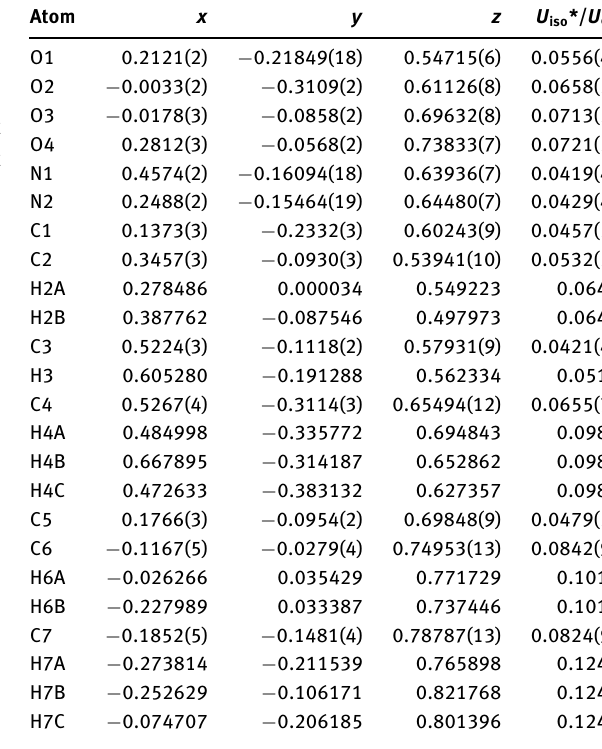
Table 2: Fractional atomic coordinates and isotropic or